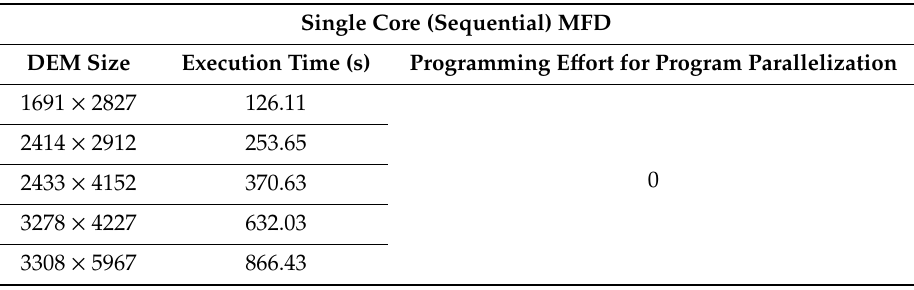
Table 1. Experimental results for Single core (sequential) MFD.